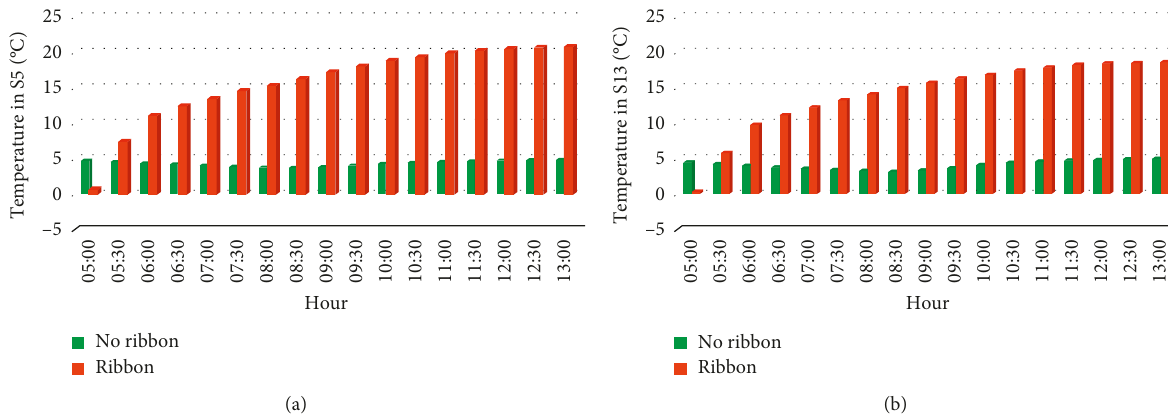
Figure 5: Heating contributions on pavements in S5 and S13, averaged in 30-minute intervals, from 5:00 to 13:00.